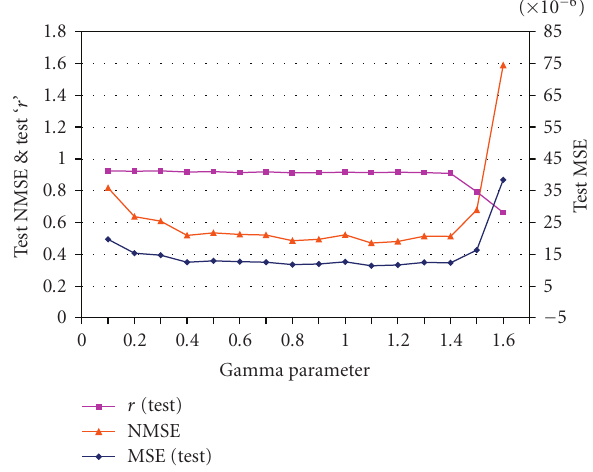
Figure 2: Choice of Gamma (CSTR lab. data).